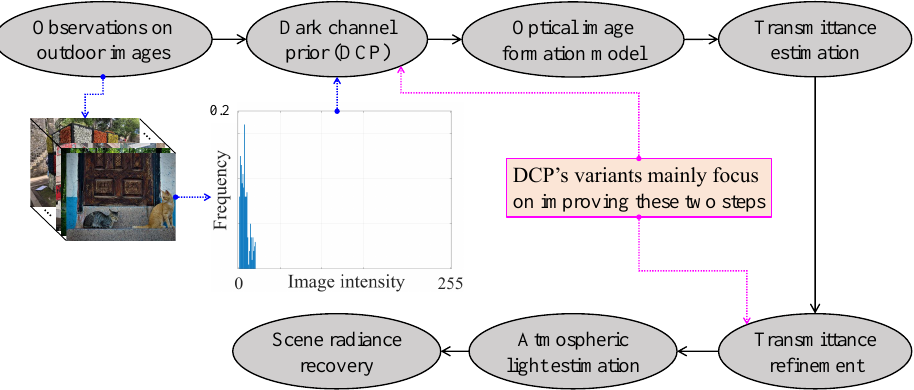
Figure 6. Simplified block diagram of dark channel prior-based visibility restoration